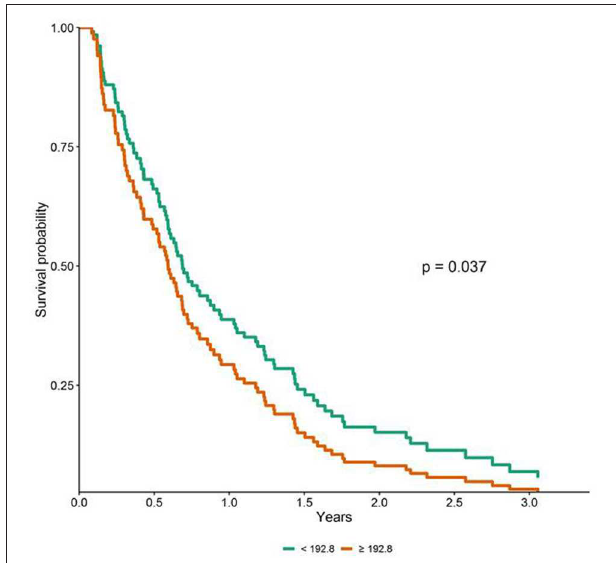
FIGURE 6 | Adjusted survival curves for overall survival (OS) in patients with pancreatic cancer according to miR-122-5p plasma levels (i.e., below and above the median